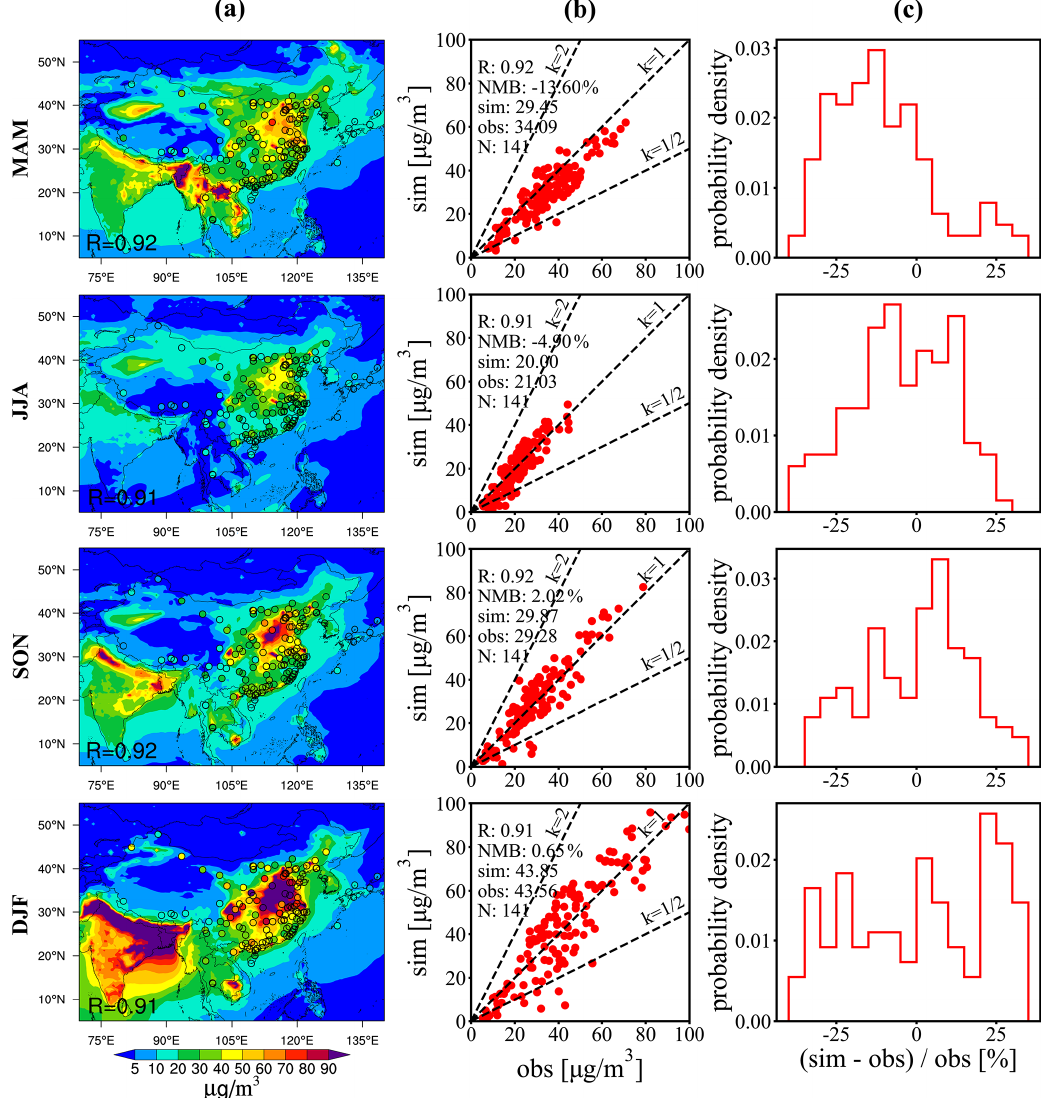
Figure 8. Comparison of surface PM 2 . 5 in East Asia. (a) Spatial distribution of simulated (shaded) surface PM 2 . 5 concentrations compared with observations (solid circles). (b) Scatterplots of simulated (sim) and observed (obs) seasonal mean PM 2 . 5 . The black dotted lines are the 2 : 1, 1 : 1, and 1 : 2 reference lines from left to right. (c) The probability density functions of